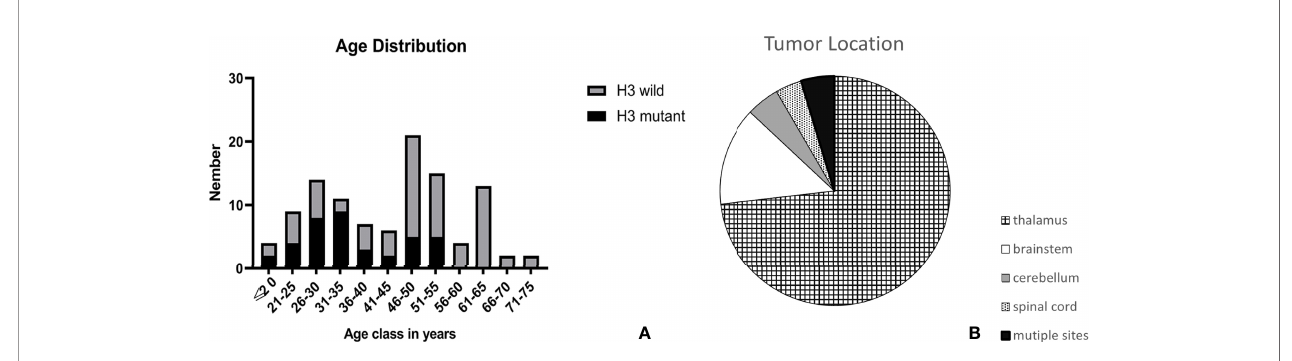
FIGURE 1 | The age (A) and location (B) distribution of tumor in